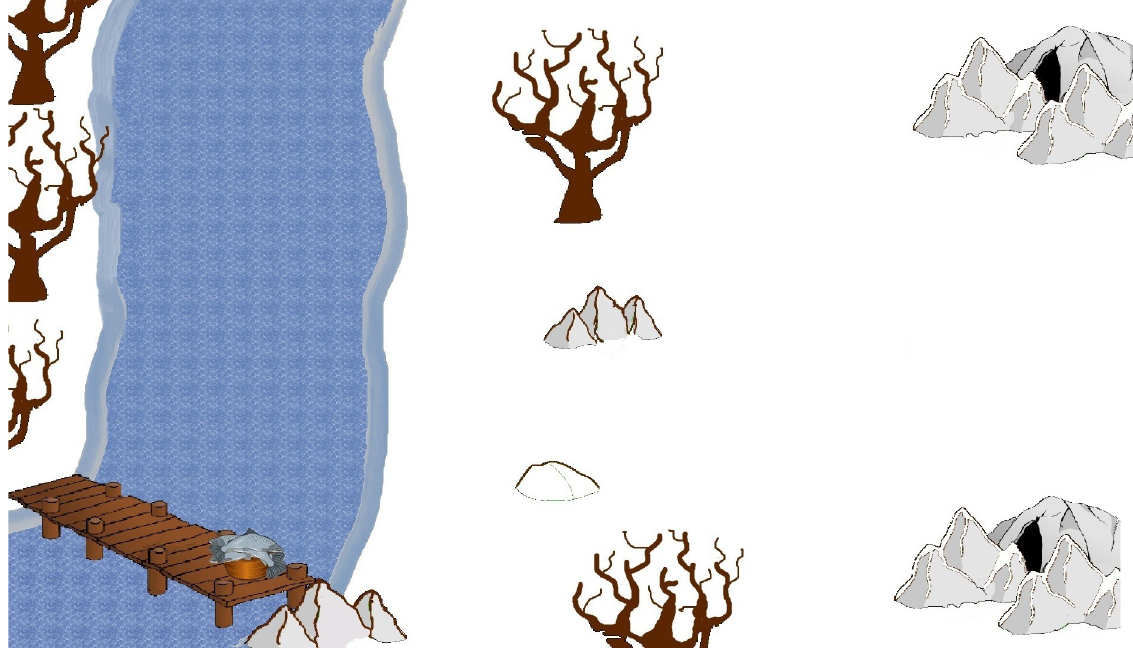
Fig 3. Context “winter” with two caves. Note that the context “Winter” for Shift-3cave had three caves. Contexts differed between the two phases (“summer” vs. “winter”) in Shift-2cave and Shift-3cave.